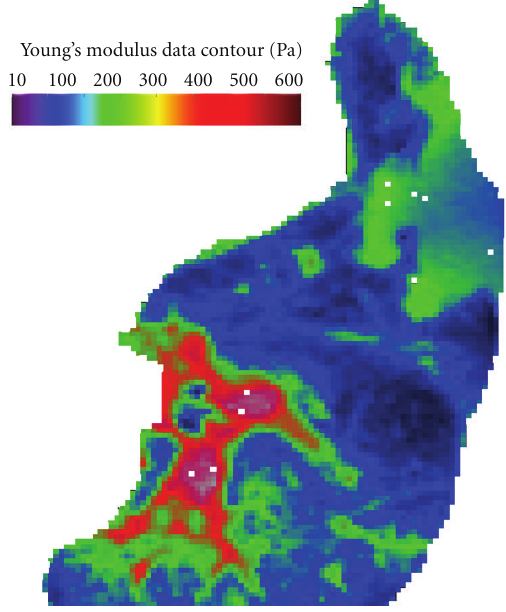
Figure 6: Anisotropic YM obtained based on 4DCT scan dataset and measured pressure-volume curves for patients with lung